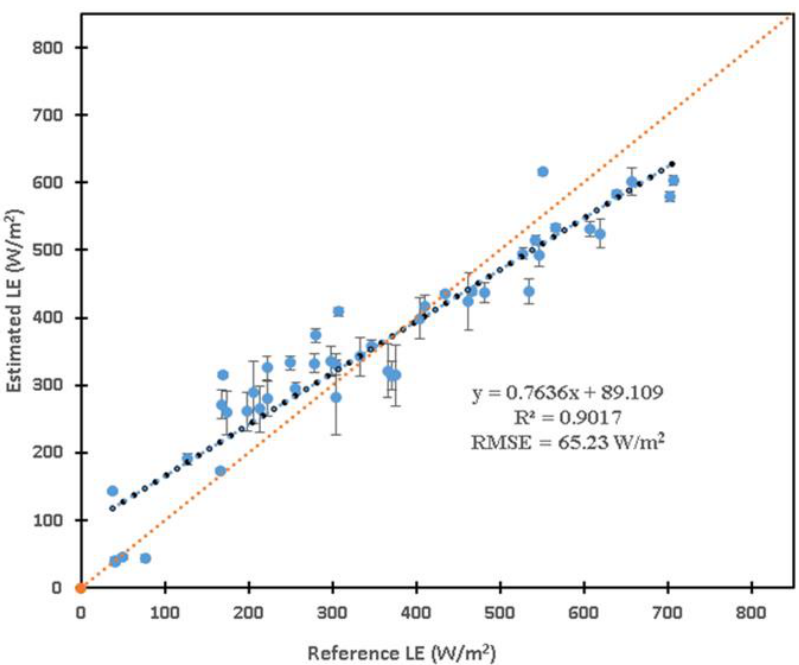
Figure 7. Scatter plot of reference latent heat flux calculated using porometer measurements versus TSEB model estimations. Symbol indicates the average value of measurements, while the error bars indicate the standard deviation of model estimates based on all pixels identified as potentially representing the location of the porometer measurements. Data is for all days of flight operations in 2018 and 2020.